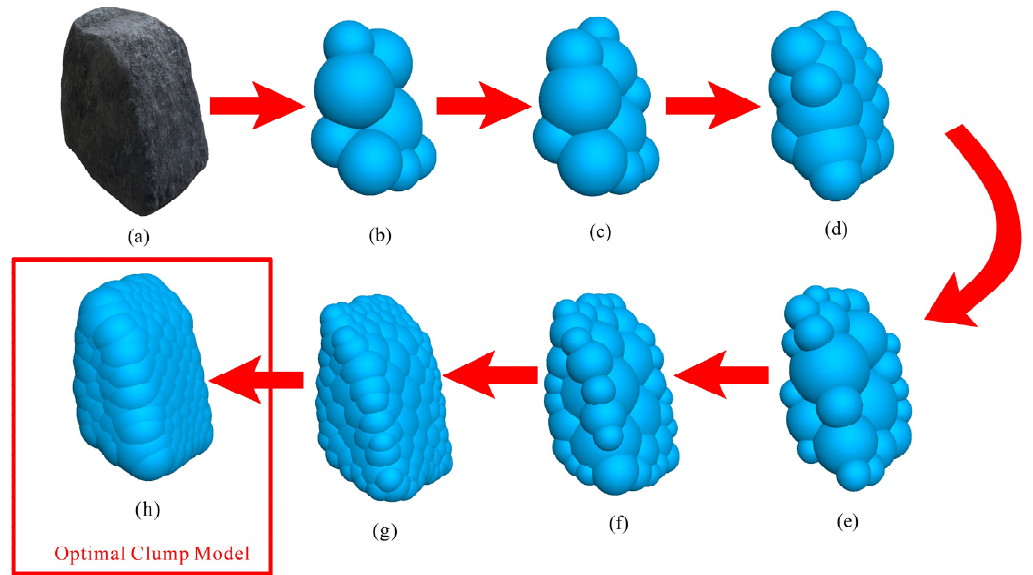
Figure 4. Generation and evolution effects of clump 1. ( a ). Coal gangue real shot; ( b ). ratio = 0.5, distance = 100; ( c ). ratio = 0.5, distance = 110; ( d ). ratio = 0.5, distance = 130; ( e ). ratio = 0.3, distance = 100; ( f ). ratio = 0.3, distance = 120; ( g ). ratio = 0.3, distance = 145; ( h ). ratio = 0.5, distance = 160.